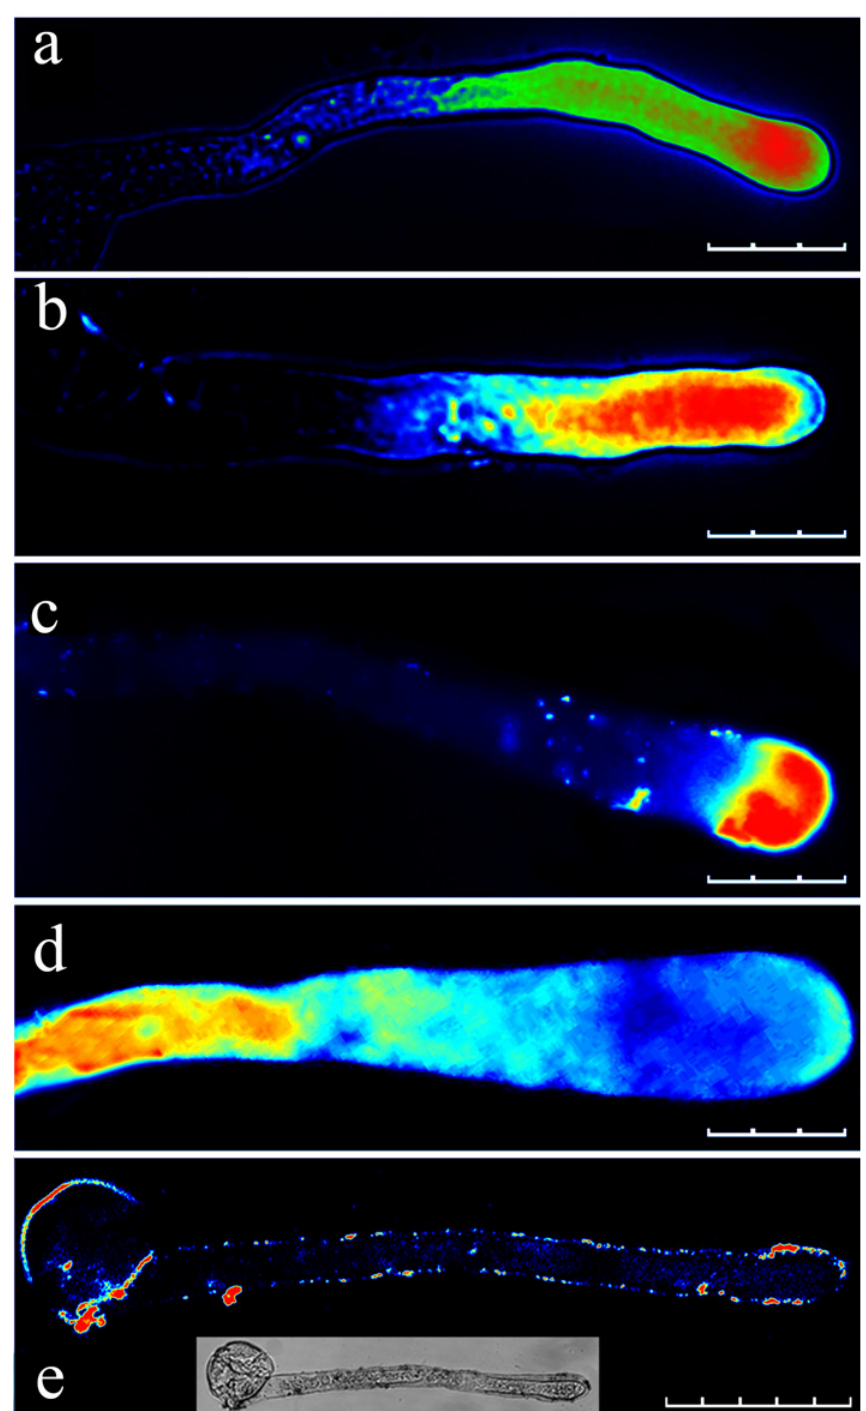
Fig 6. Effect of different concentrations of La 3+ on the calcium gradient in the pollen tube apical regions. (a) Pollen tube loaded with fluo-4/AM without La 3+ (control). Pollen tubes after loading with fluo-4/ AM followed by the addition of 10 μ M La 3+ (b), 100 μ M La 3+ (c), and 1 mM La 3+ (d). (e) Pollen tube after loading with fluo-4/AM in the presence of 1 mM La 3+ . Scale bars: 100 μ m (a), 90 μ m (b and c), 60 μ m (d) and 70 μ m